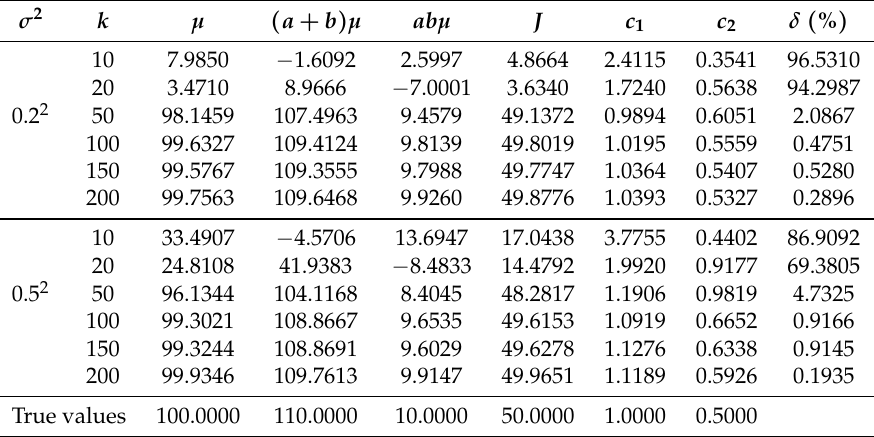
Table 2. The MIRLS estimates and errors ( p =